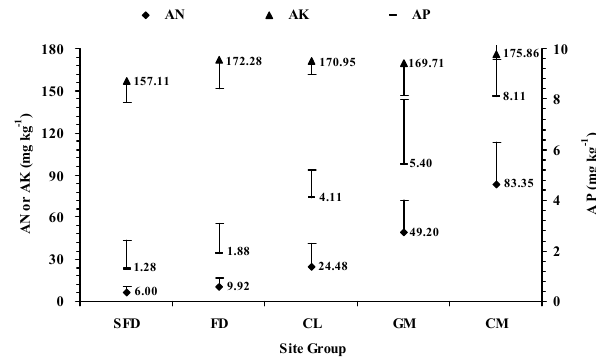
Fig. 8. The soil available N (AN), available P (AP), and available K (AK) of the study area. Values are means ± standard deviations. SFD stands for semi-fixed dune sites, FD for fixed dune sites, CL for cultivated land sites, GM for general meadow sites, and CM for control meadow sites where there was no detectable erosion and sand accumulation.